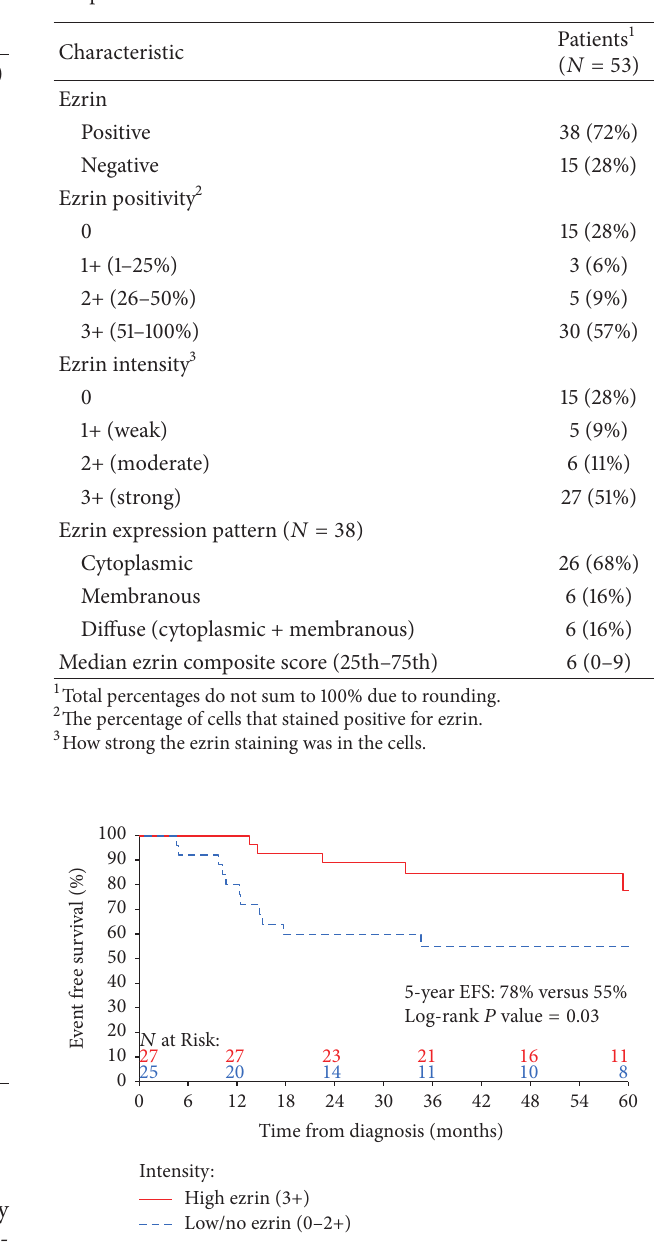
Table 1: Clinical characteristics of 53 patients with Ewing sarcoma. Table 2: Ezrin expression in 53 diagnostic Ewing sarcoma tumor samples.